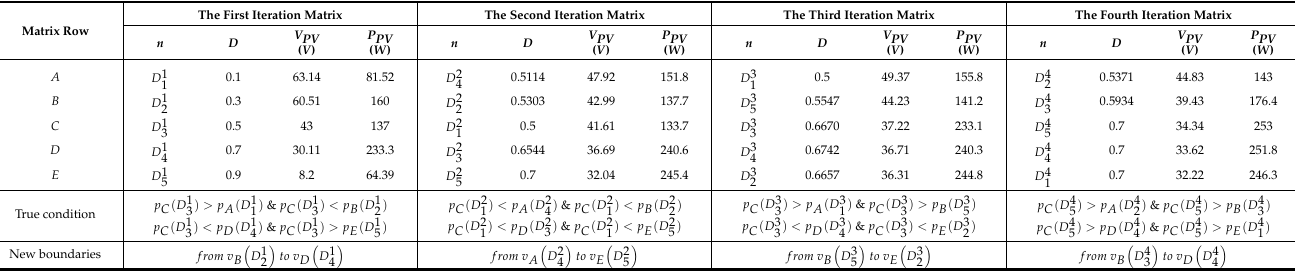
Figure 9. The GMPP tracking method for pattern-2. ( a ) The samples’ operating points at the first four iterations. ( b ) The tracking performance by using CSA. ( c ) The tracking performance by using ICSA. Table 6. The rearranged and saved data for pattern-2.